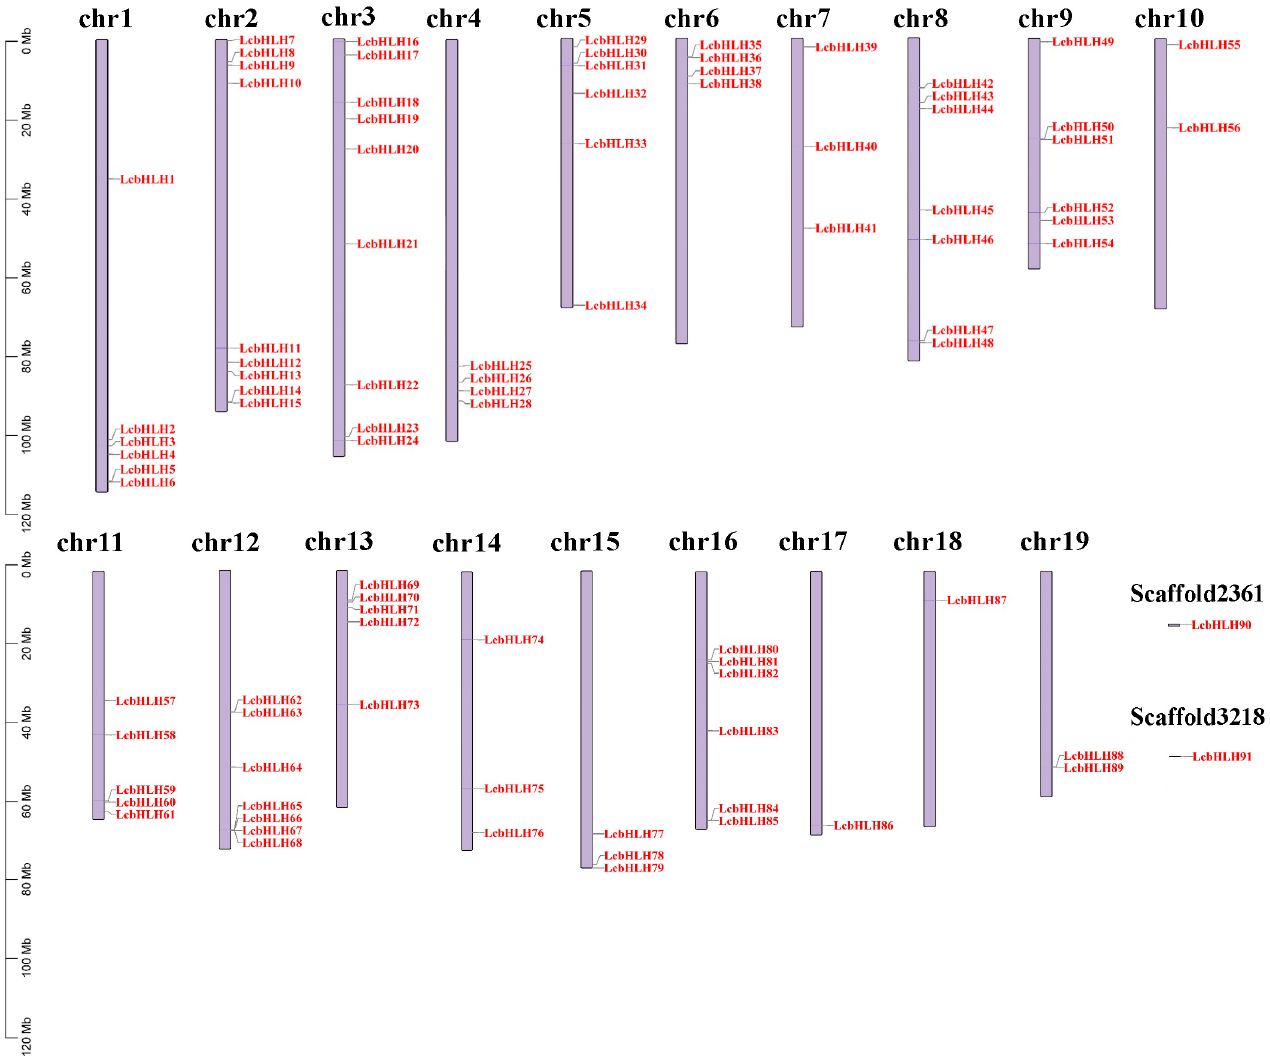
Figure 4. Chromosome distribution of LcbHLH gene. Ninety-one genes were labeled on 19 chro- mosomes and two scaffolds. Positional information for each LcbHLH gene is displayed on each chromosome (chr). The left scale represents the length of the chromosome.